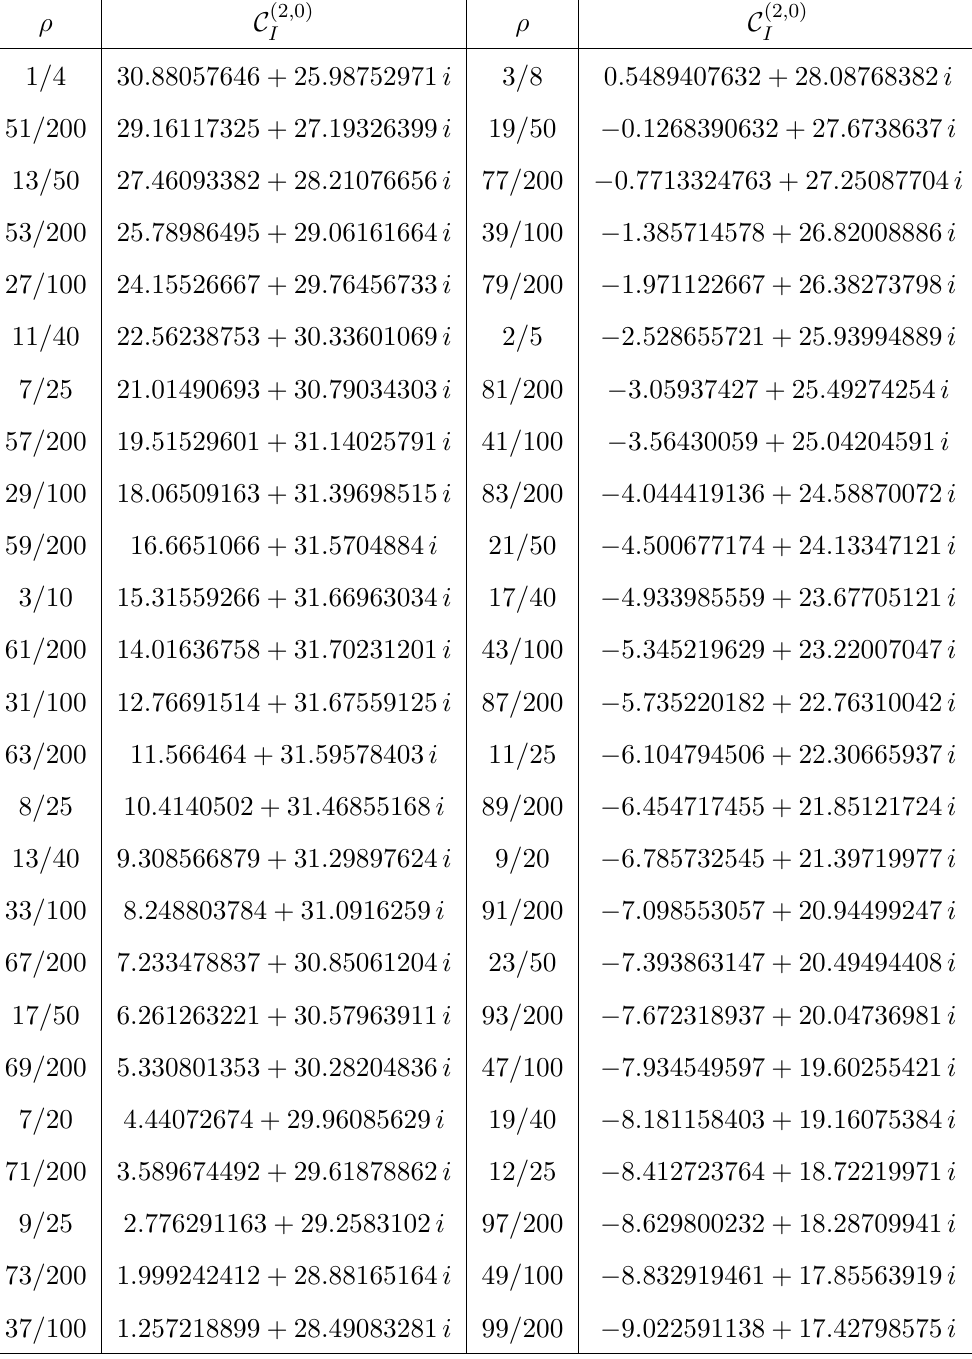
Table 1 . Numerical values of the three-loop coe(cid:14)cient of the (cid:12)nite remainder C (2)